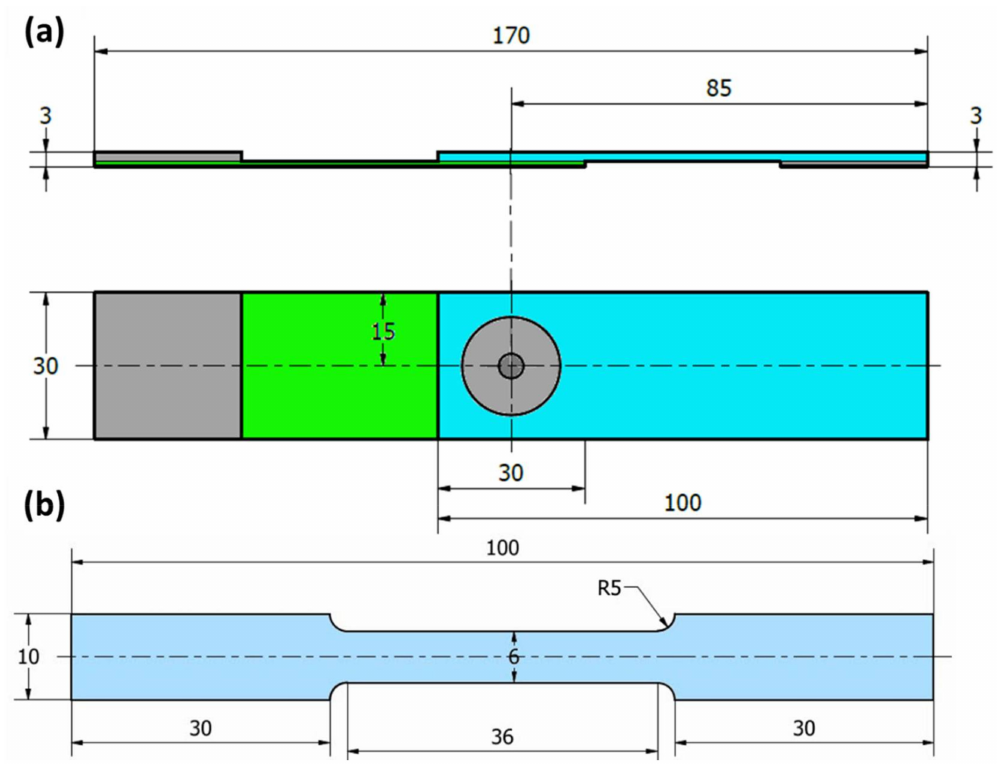
Figure 3. Schematic drawing of ( a ) tensile/shear test samples of FSSW lap joints, ( b ) tensile test sample of AA6082-T6 BM. (All dimensions in mm).